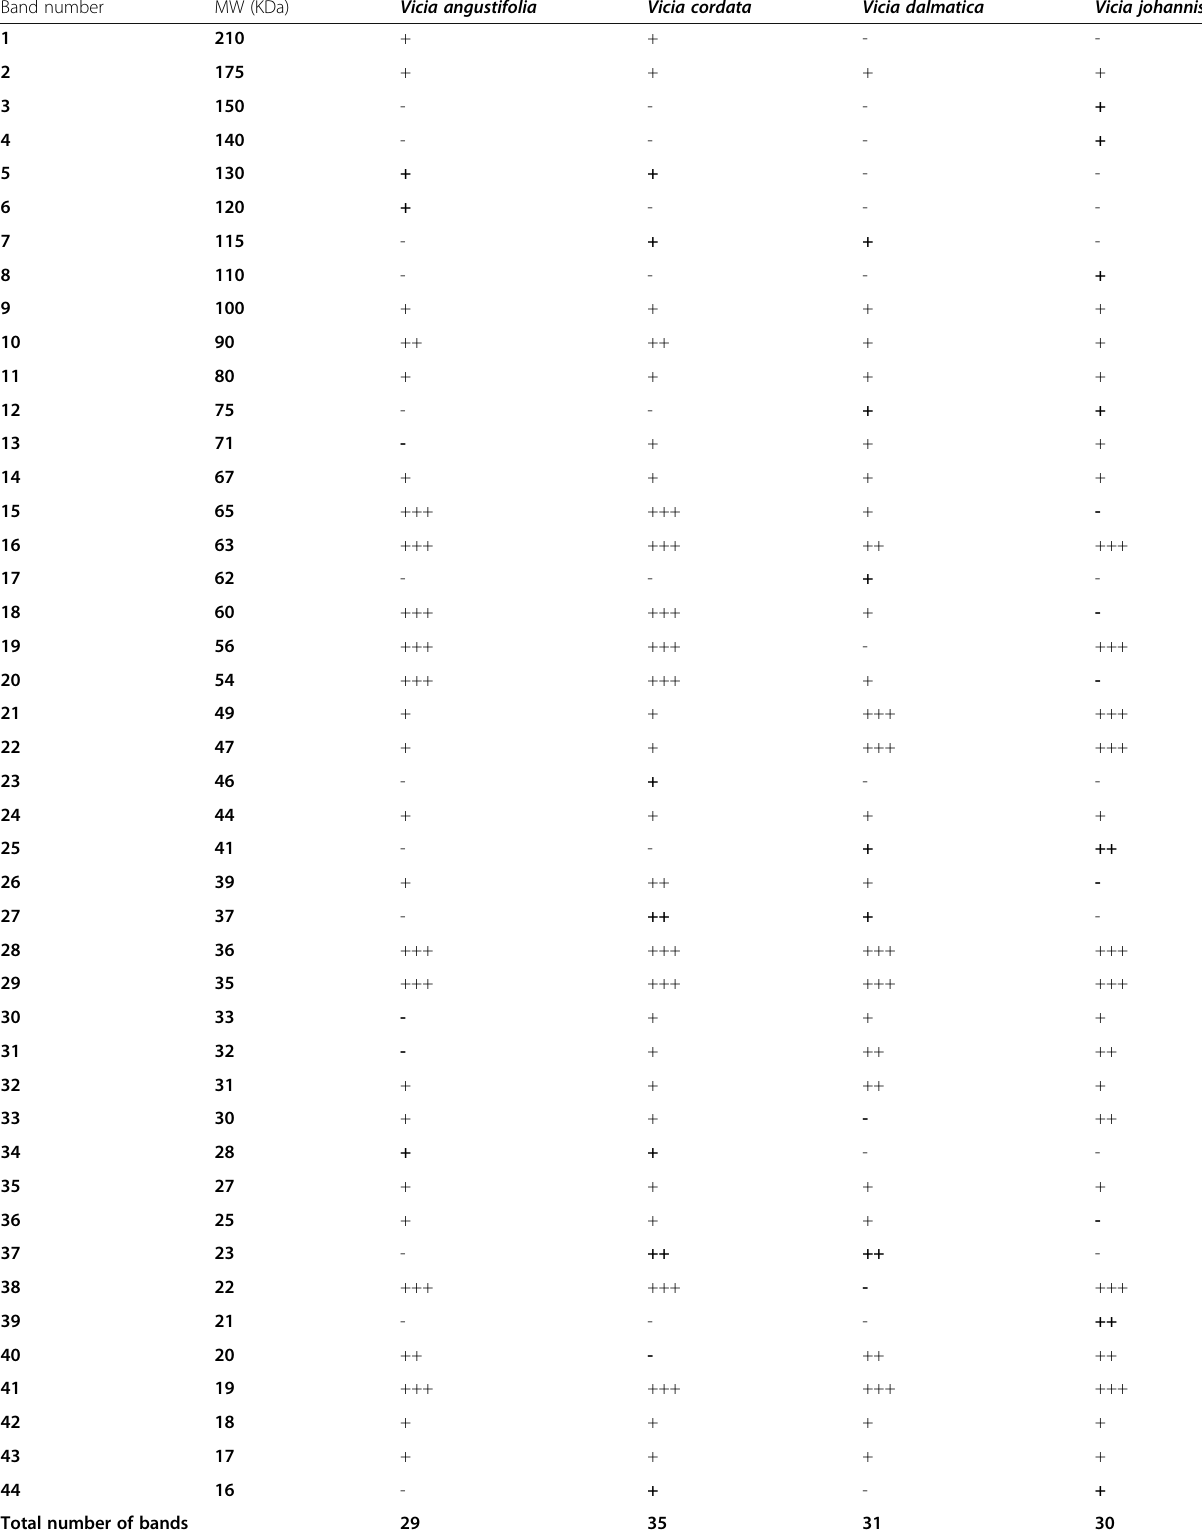
Table 1 Approximate molecular weight and intensity of total seed storage protein bands in four Vicia species Band number MW